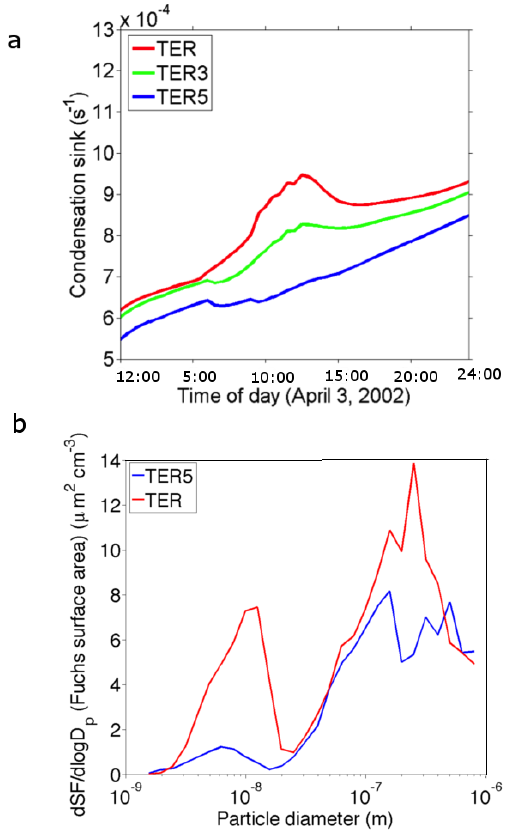
Figure 7. Visualization of condensation sink (a) and particle sur- face area size distribution (b) , for 3 April 2002 at Hyytiälä. Fuchs surface area size distributions are shown for a 12:00 time slice in the nucleation event on 3 April